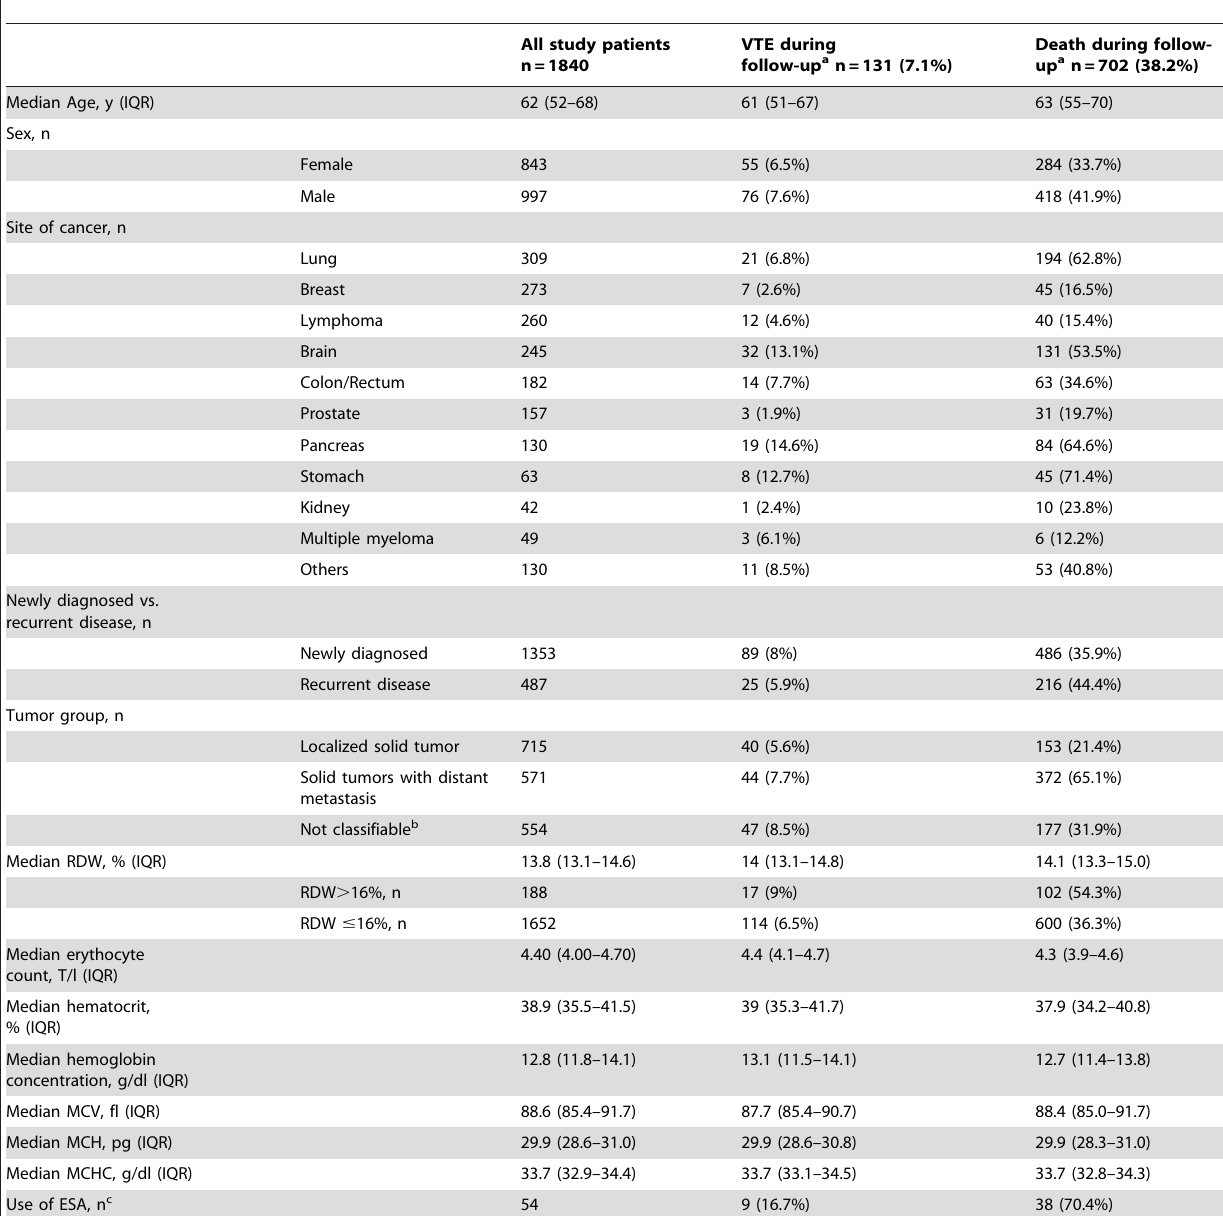
Table 1. Characteristics of the total study population, of patients who developed venous thromboembolism (VTE) and of patients who died during the observation period, as recorded at the time of entry into the study.